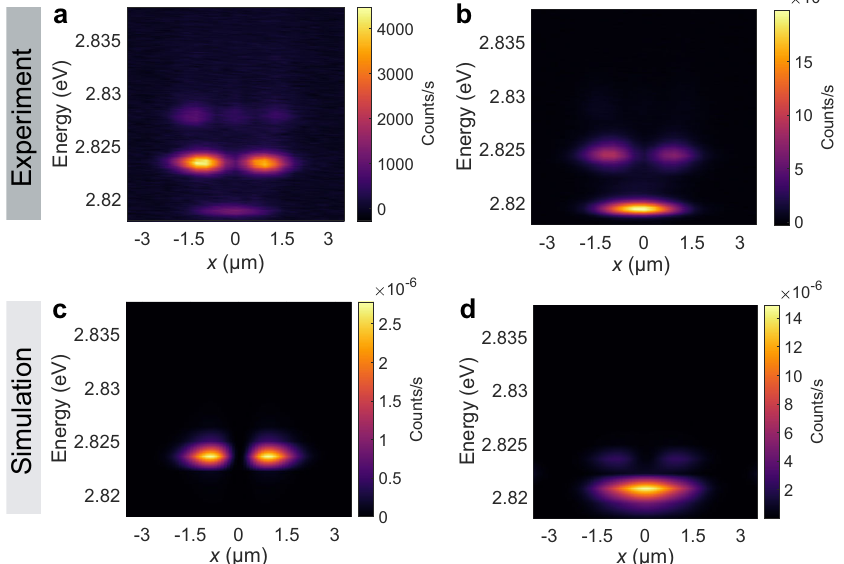
Fig. 3 | Power dependence of polariton occupation on different quantised states. a , b Spatially resolved spectra of the cavity excited by two pump spots separated by 5.6 μ m at pump powers of 4.7 μ W ( a ), 7.4 μ W ( b ). c , d Theoretically